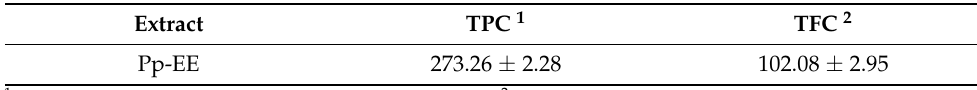
Table 1. Total phenolic and flavonoid content of Pp-EE. Extract TPC 1 TFC 2 Pp-EE 273.26 ±